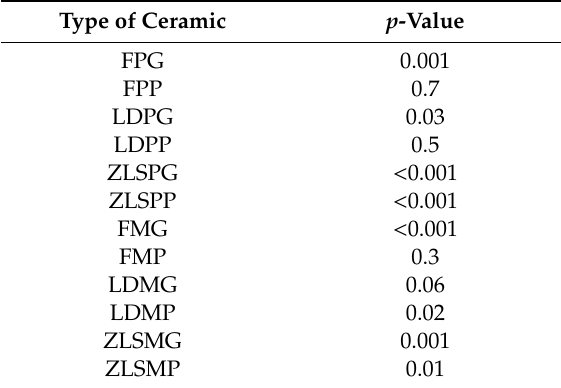
Table 5. TP values before and after thermocycling.